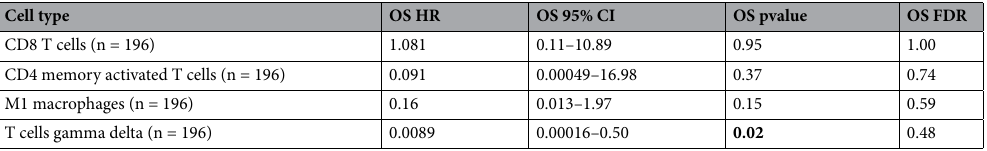
Table 5. Prognostic value of immune cell types in METABRIC TNBC (univariate) (continuous). Bold : pvalue < 0.05. METABRIC: Molecular Taxonomy of Breast Cancer International Consortium; TNBC: triple negative breast cancer; OS: overall survival; HR: hazard ratio; FDR: false discovery rate; CI: confidence interval.